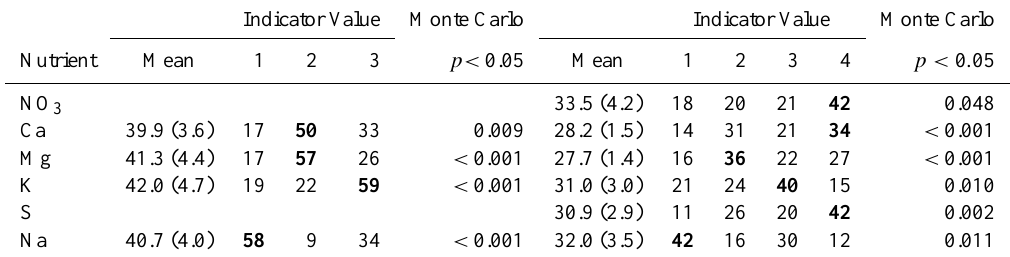
Table 3. Nutrient indicator species analysis associated with site groups. Each value represents the mean indicator with standard deviation in parentheses, and the highest indicator value is in bold. Only nutrients that were found to be significantly different among groups are presented. The left side of the table shows comparison among natural ecosites (Groups 1, 2, and 3), while the right side shows comparison among all